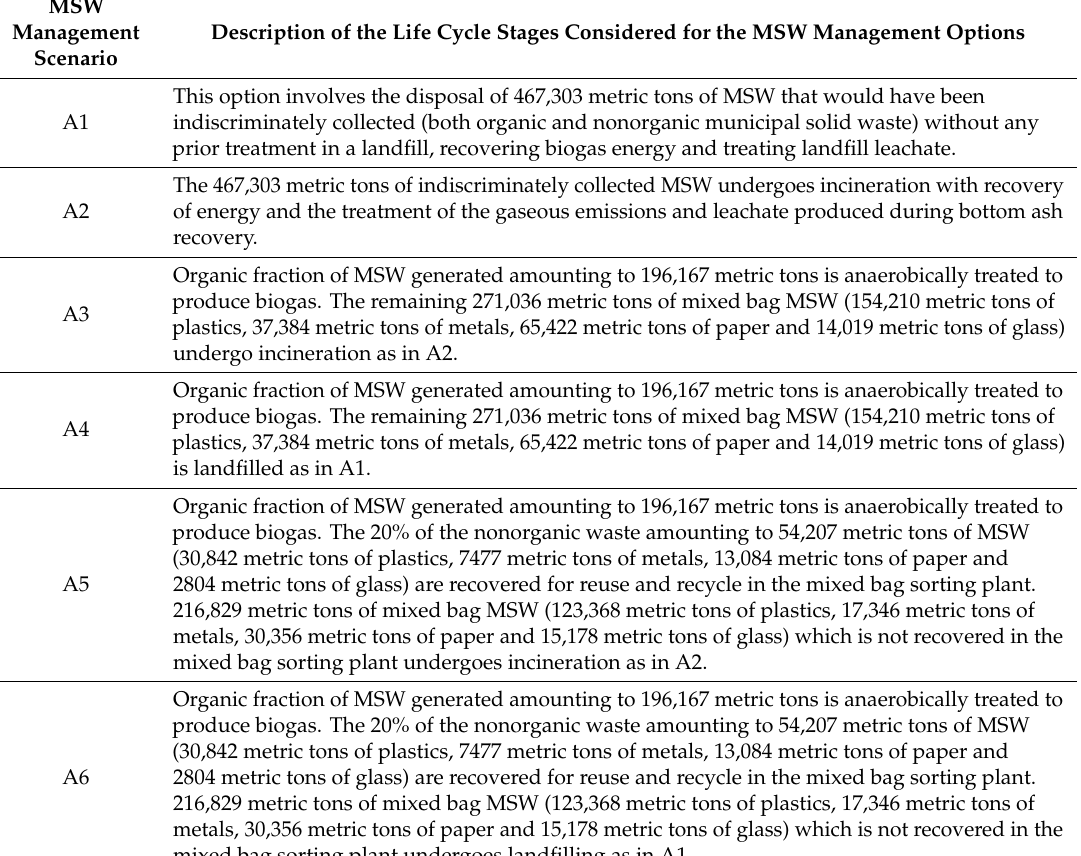
Table 4. Description of considered MSW management